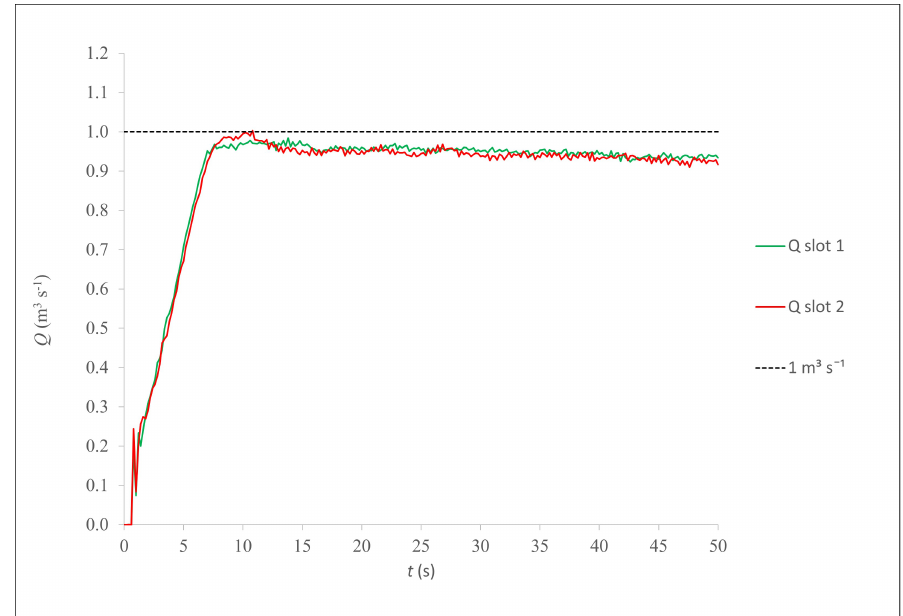
Figure 5. Discharge in the numerical pool as observed from the calibrated